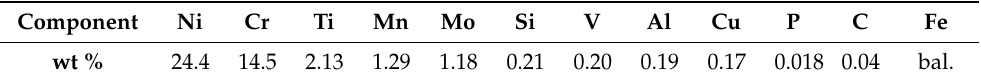
Table 1. Composition of A286 in wt %.